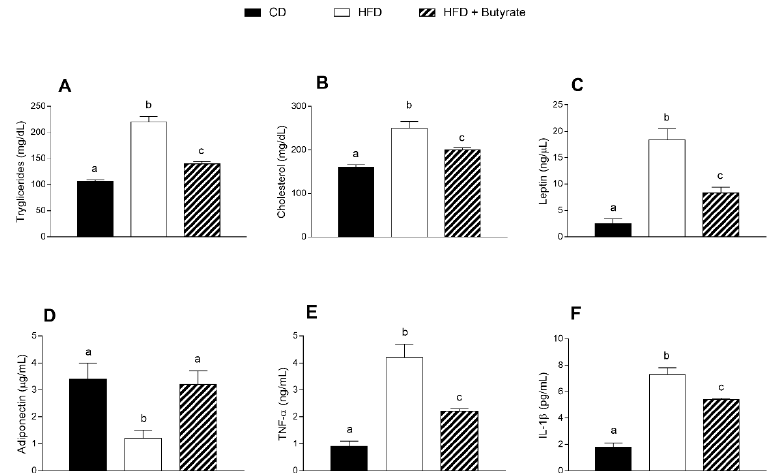
Figure 2. Effects of butyrate treatment on serum parameters in diet-induced obese mice: ( A ) triglycerides; ( B ) cholesterol; ( C ) leptin; ( D ) adiponectin; ( E ) TNF- α and ( F ) IL-1 β serum levels are reported. Data are shown as means ± SEM from n = 6 animals/group. Different letters (a,b,c) on top of the bars indicate statistically significant differences ( p < 0.05) among groups.